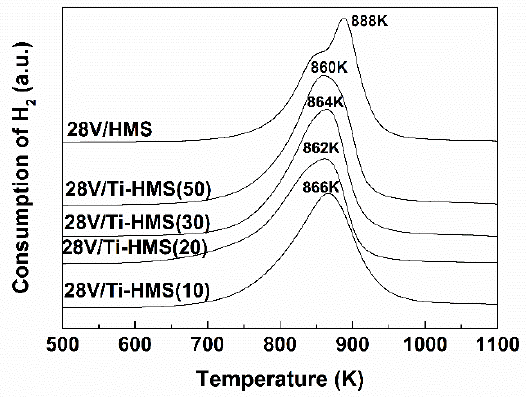
Figure 8. Temperature programmed reduction (TPR) profiles of catalysts with different supports.